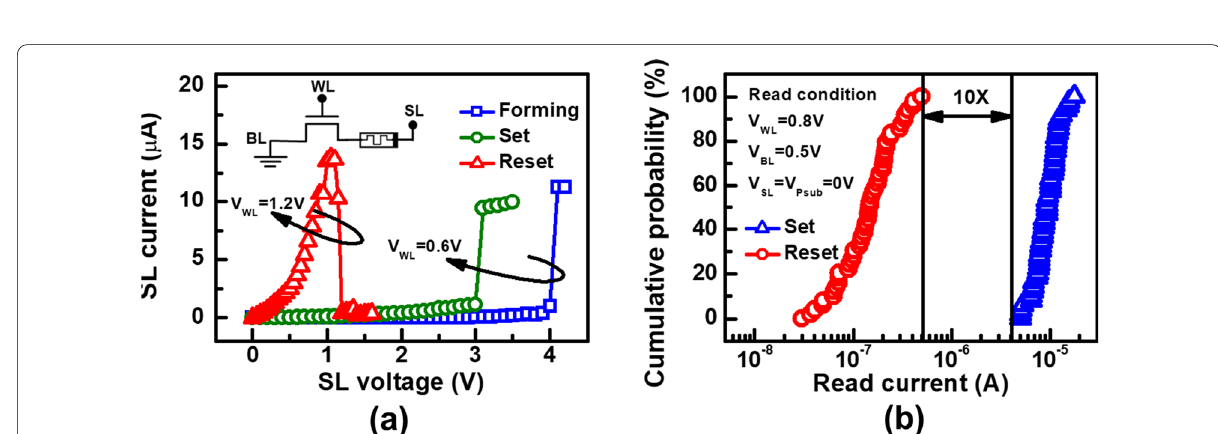
Fig. 4 a DC forming/set/reset sweep characteristics, which bit lines (BL), are grounded. b Current levels after 50 set/reset operations. LRS/HRS are defined as 5 μA/0.5 μA, respectively, to obtain 10 on/off ×